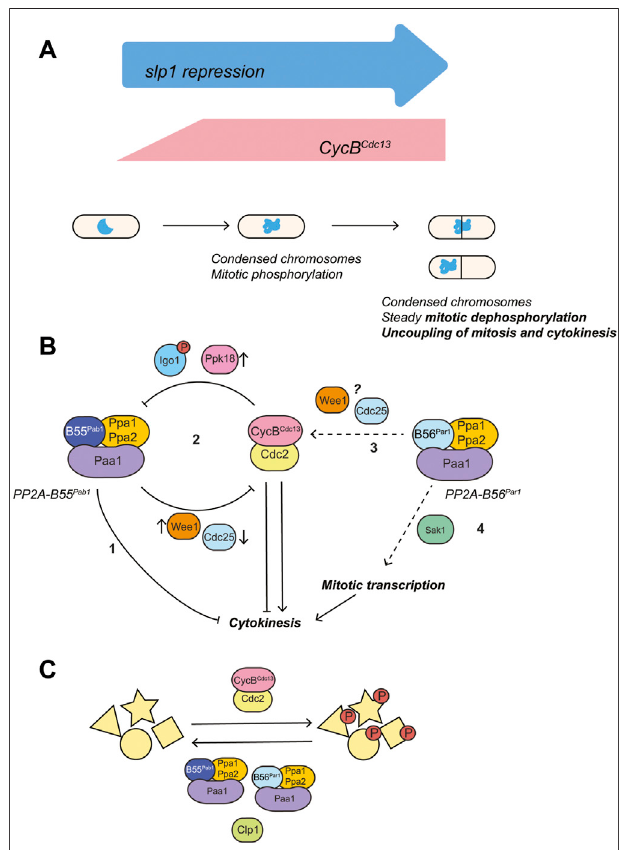
FIGURE 8 | Proposed model for the regulation of cytokinesis by PP2A phosphatasesandmitoticCDKcomplexduringaprolongedmitoticarrest. (A) Mitotic arrest was induced through transcriptional repression of the APC/C activator Slp1 (under the control of the thiamine-repressible promoter